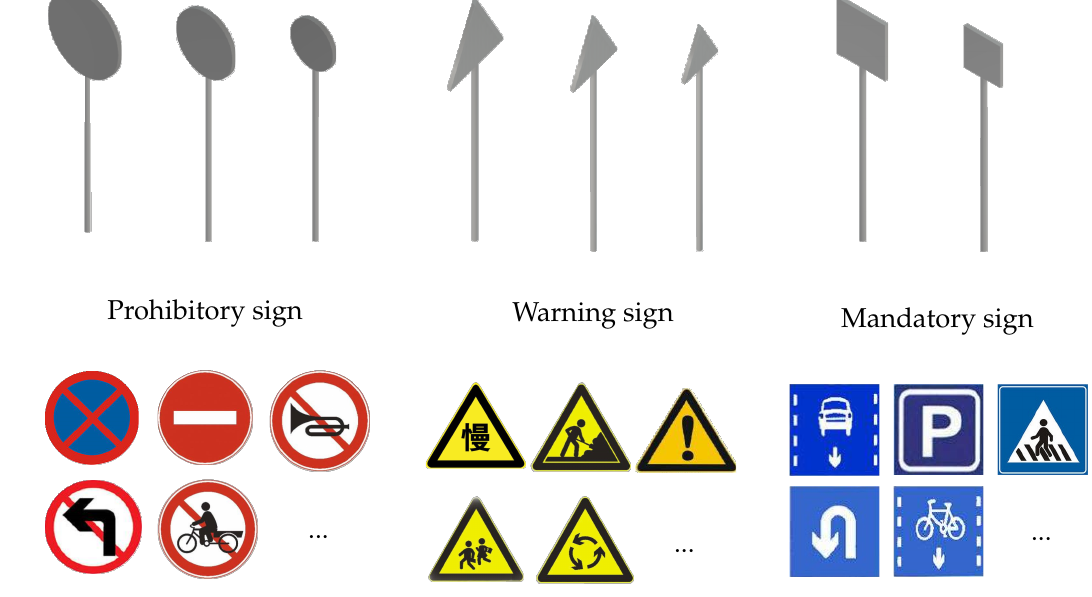
Figure 8. 3D templates and texture database of road signs.